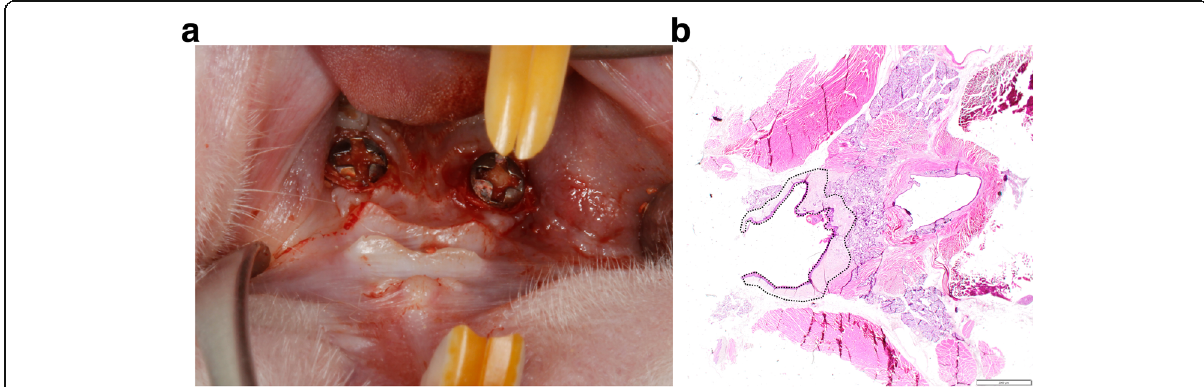
Fig. 1 a Chronic-type peri-implant infections were induced at titanium implants placed in the upper jaw of rats. Bleeding on probing pointing to clinical signs of inflammation at ligature removal. b Depiction of the region of interest (i.e., the inner and outer confines of the lateral pharyngeal and retropharyngeal connective tissue zone) in the horizontal plane for the histological